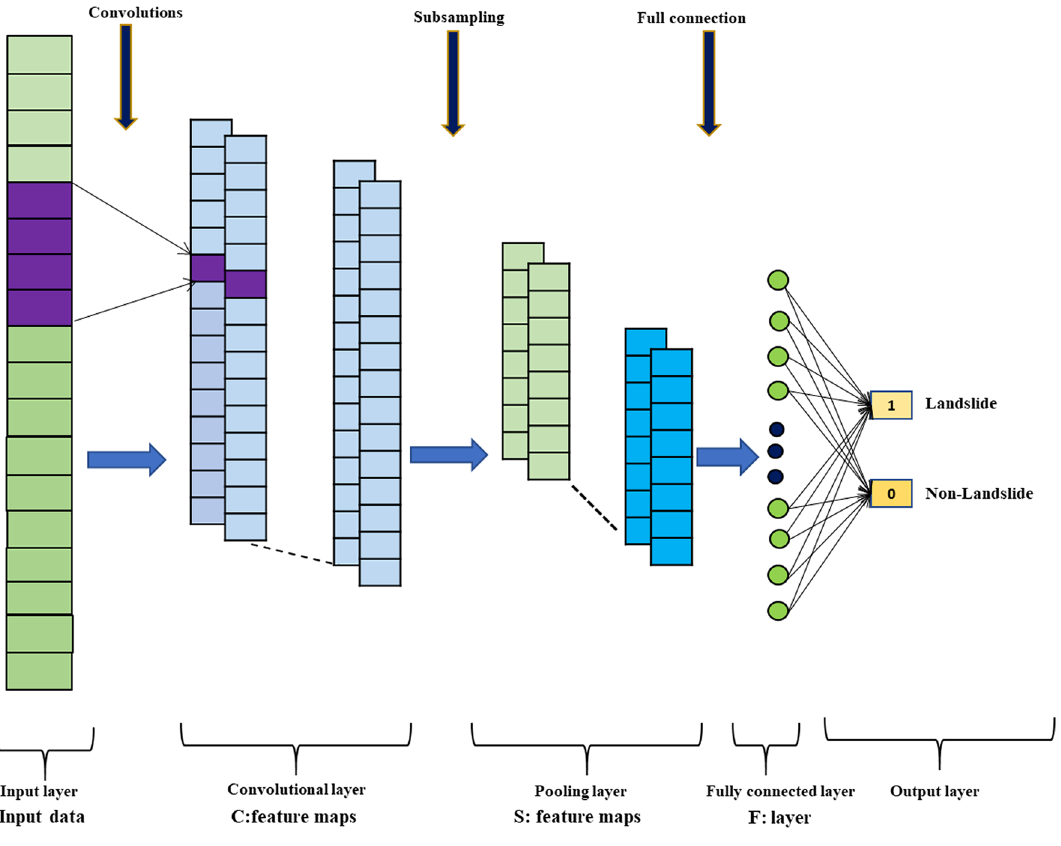
Figure 6. Theoretical structure of used CNN